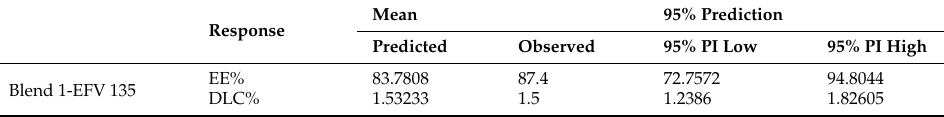
Table 11. Optimized encapsulation efficiency and drug loading